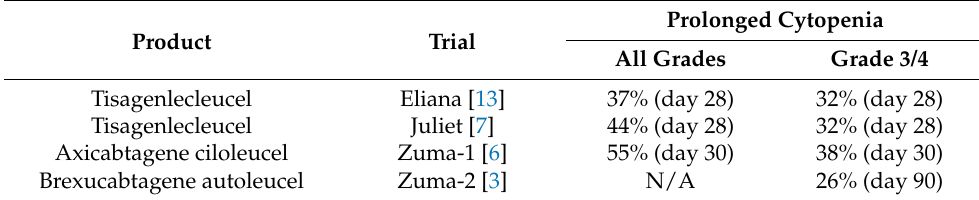
Table 1. Occurrence of late cytopenias in pivotal clinical